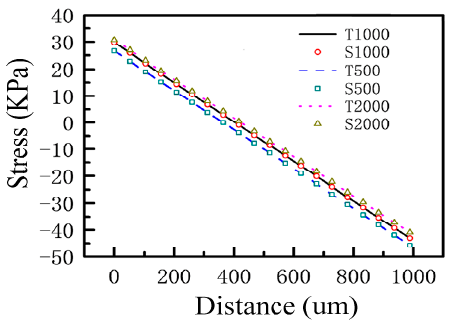
Figure 8. The effects of the length of the beam on the stress distribution.